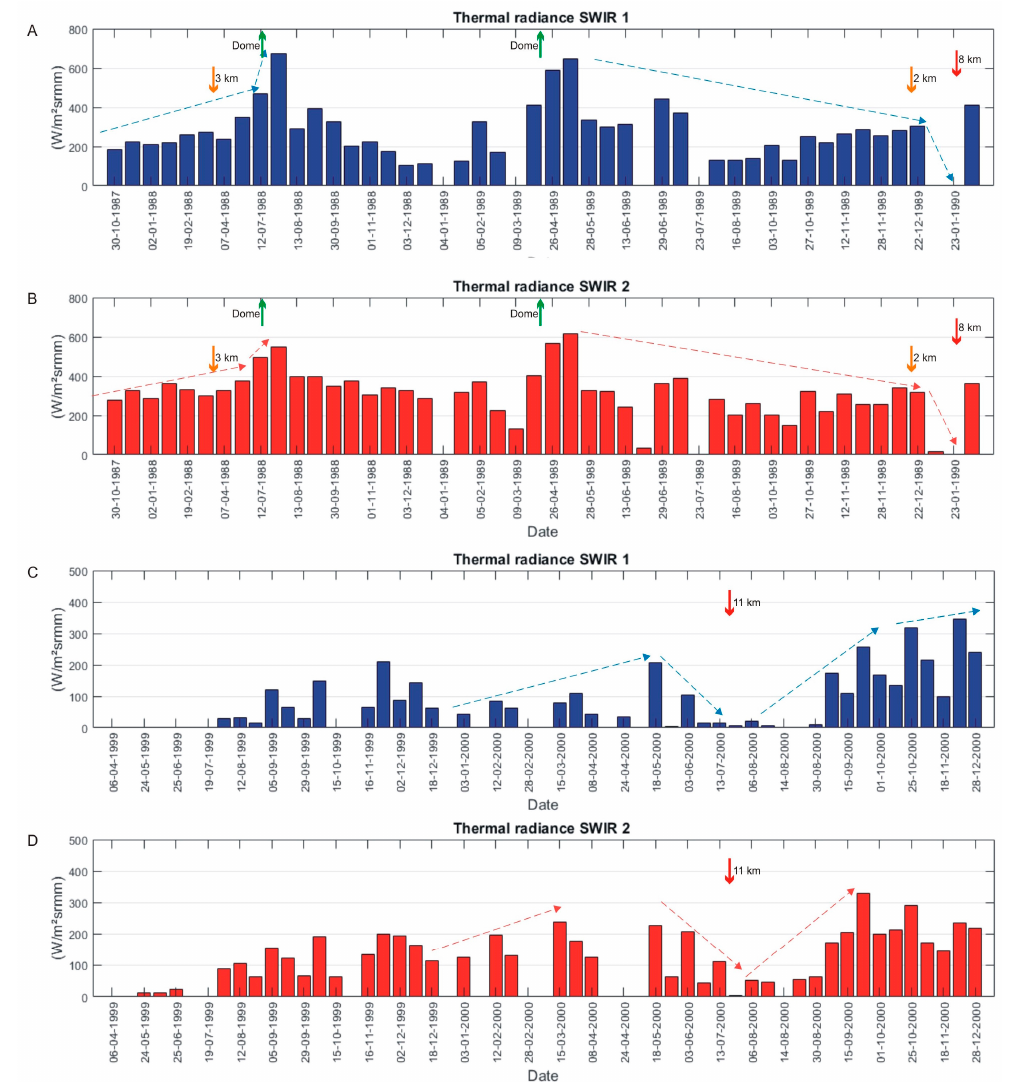
Figure 9. Lascar Volcano. Thermal radiance versus date graphics, showing the most relevant volcanic activity. Red and orange downward arrows show major and minor eruptive activity, respectively, whereas green upward arrows show records of lava domes. Zero values correspond to absence of thermal anomaly. ( A ) Thermal radiance of SWIR1 band for lava dome-and-growth cycle 2 during phase 1 . ( B ) Thermal radiance of SWIR2 band for lava dome-and-growth cycle 2 during phase 1 . ( C ) Thermal radiance of SWIR1 band for the period April 1999–December 2000 during phase 2 . ( D ) Thermal radiance of SWIR2 band for the period April 1999–December 2000 during phase 2 .